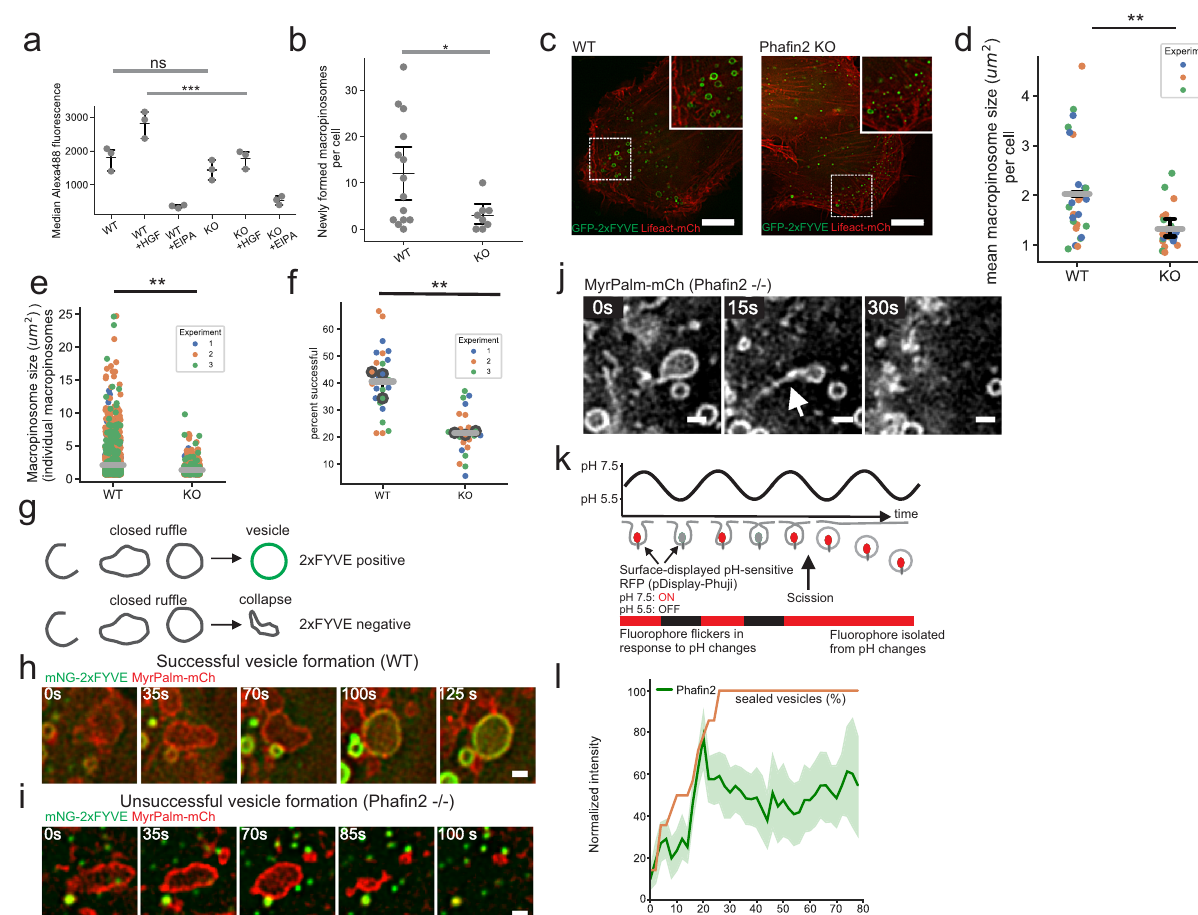
Fig. 5 Pha fi n2 is required for ef fi cient macropinocytosis. a Flow cytometry measurement of dextran uptake (10 kDa, Alexa488) in WT and Pha fi n2 knockout cells. Pha fi n2 knockout cells show reduced dextran uptake under stimulated conditions. n = 3 experiments, mean + 95% CI, ANOVA with Tukey ’ s post-test, p < 0.0001. *** p < 0.001, n.s. not statistically signi fi cant. b Formation of new macropinosomes (> 1 um in diameter) in Pha fi n2 WT and KO cells. Macropinosome formation was scored over 20 min of imaging time. n = 14 (wt) and 8 (KO) cells, mean + 95% CI, two-sided t-test, p = 0.043. * p < 0.05. c Exemplary image showing macropinocytosis in WT and Pha fi n2 knockout cells (single frame extracted from the movies analyzed in ( d )). Scale bar: 10 µ m. d Pha fi n2 knockout cells have smaller macropinosomes than WT cells. Plotted are the mean macropinosome size (> 0.64 µ m² area) per individual cell and the mean per experiment + 95% CI. n = 3 experiments, two-sided t-test, p = 0.0026. e Pha fi n2 knockout cells are unable to form large macropinosomes. Plotted is the size of individual macropinosomes (> 0.64 µ m² area) and the mean per experiment + 95% CI. n = 3 experiments, two- sided t-test, p = 0.0076. f Pha fi n2 knockout cells are less successful in forming macropinosomes. Plotted is the success rate per individual cell and the mean per experiment + 95 % CI. n = 3 experiments, two-sided t-test, p = 0.0038. g Schematic showing the phenotypes scored in f . h Sequential images showing successful macropinosome formation in WT cells. Scale bar: 1 µ m. Representative images for n = 25 cells. i Sequential images showing collapsing macropinosomes in Pha fi n2 knockout cells. Scale bar: 1 µ m Representative images for n = 24 cells. j Sequential images showing macropinosome-associated tubules during collapse of a macropinosome. Scale bar: 1 µ m Representative image for 15 cells. k Assay measuring the closure of macropinosomes. Cells displaying pH-sensitive pHuji-RFP on their surface were alternatingly perfused with buffers at pH 5.5 and 7.5, and localization of Pha fi n2 was evaluated in comparison to pHuji. l Quanti fi cation of Pha fi n2 localization to forming macropinosomes in relation to vesicle sealing. n = 15 macropinosomes, mean + 95% CI. Statistics source data and detailed statistics for a , b , d – f , and l are provided in this (Fig. 7a, b). This led us to ask if Pha fi n2 could in fl uence actin dynamics at forming macropinosomes.